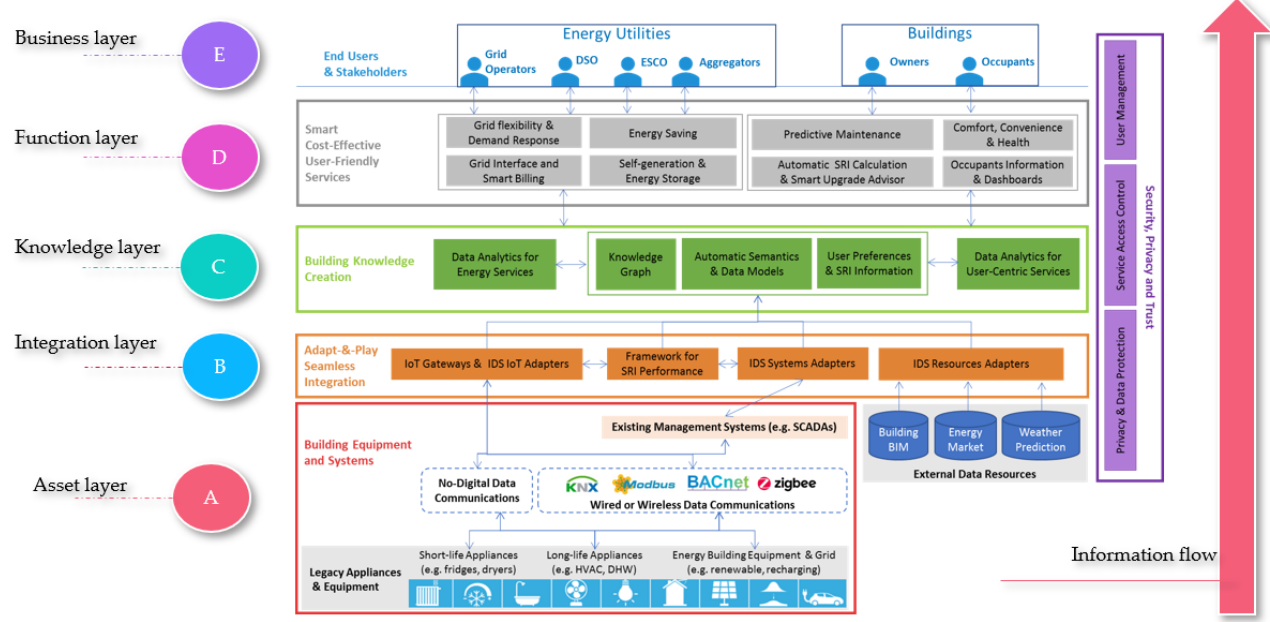
Figure 2. PHOENIX-architecture diagram.